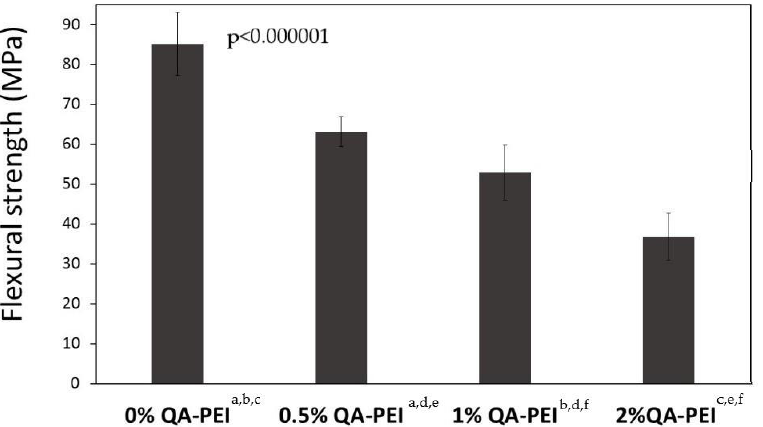
Figure 15. σ values of the materials. All the results for σ were statistically significant ( p ≤ 0.05) and they are marked with the lower case letters.